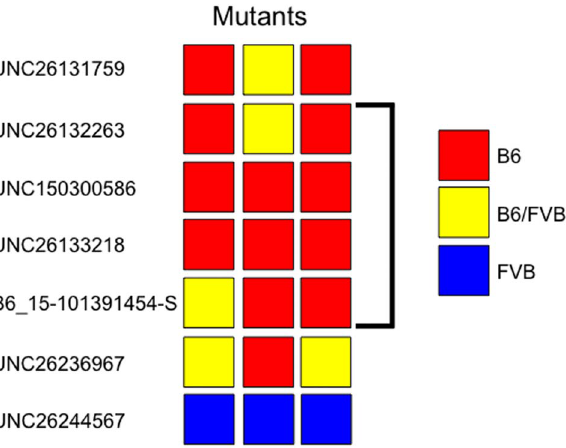
Fig. 3. SNP mapping of the MC13 mutants. A whole-genome SNP panel indicates a region of homozygosity among three MC13 mutant samples. SNPs matching the B6 genome are indicated in red, FVB in blue and heterozygous in yellow. The three mutants show a B6 (ENU-treated) haplotype between SNPs UNC26132263 and B6_15-101391454-S.